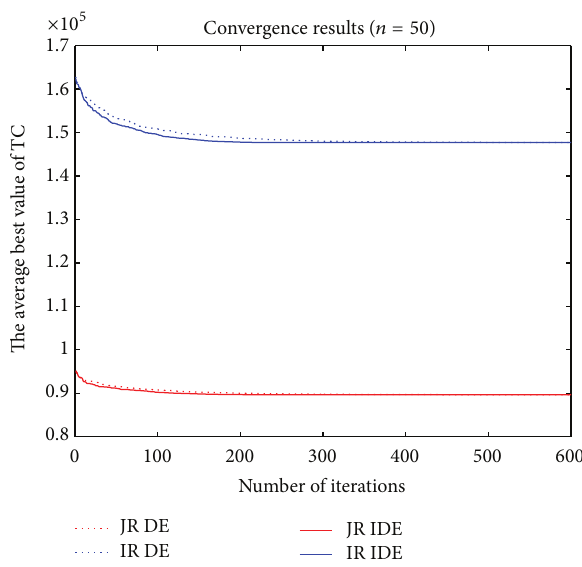
Figure 8: The average convergence curves ( 𝑛 = 50